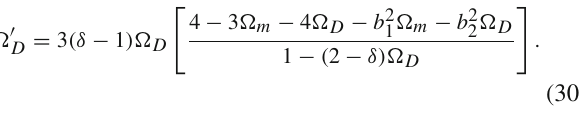
and b 2 , as indicated in panel 1 2